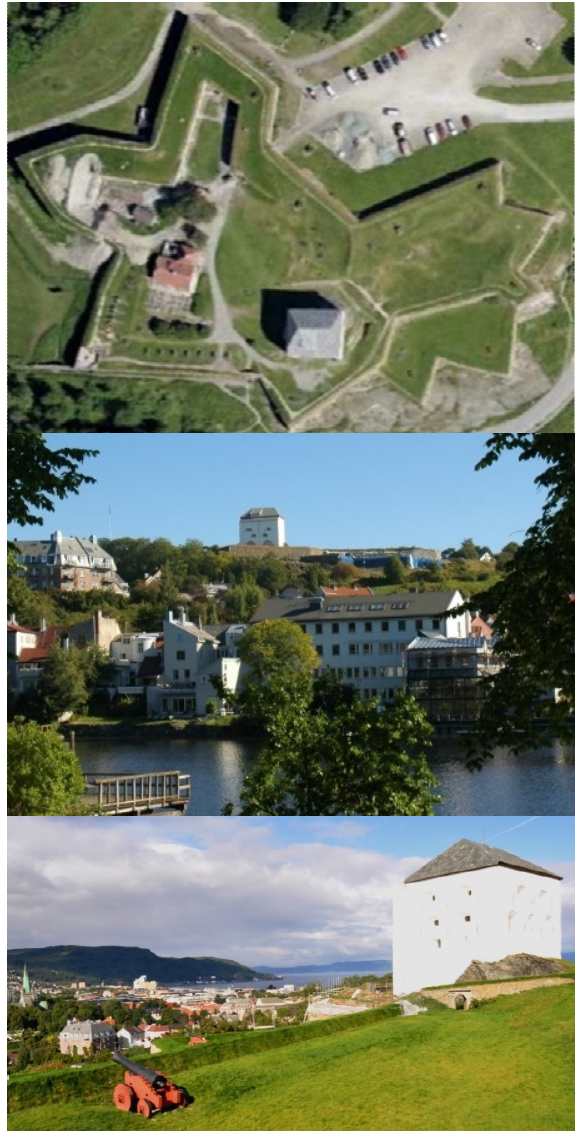
Figure 1: Fortification Kristiansten in Trondheim – nadir aerial photo (top, Google Earth), view from the city to the defence tower Donjon (centre) and view to the city